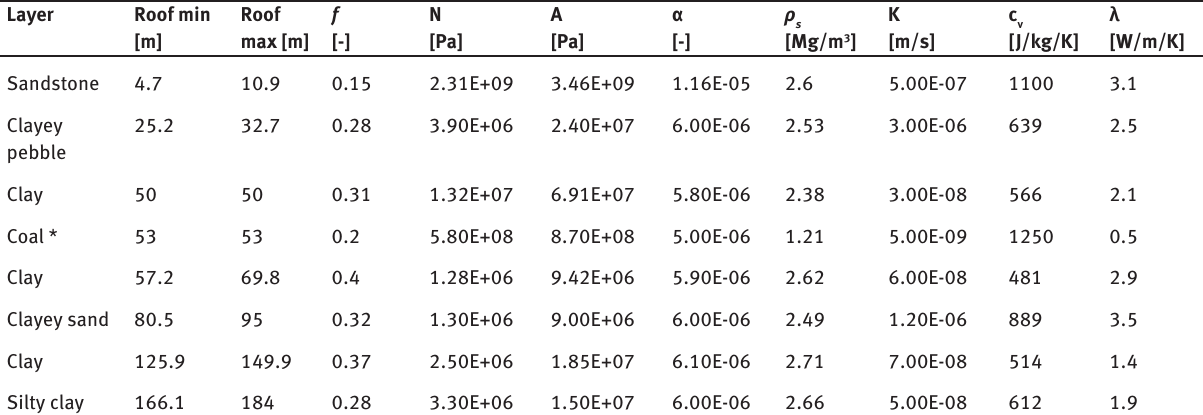
Table 1: Material parameter values of individual geological layers.